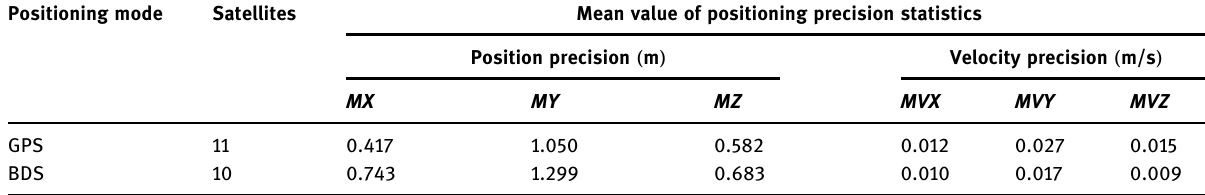
Table 2: Mean value of positioning precision statistics Positioning